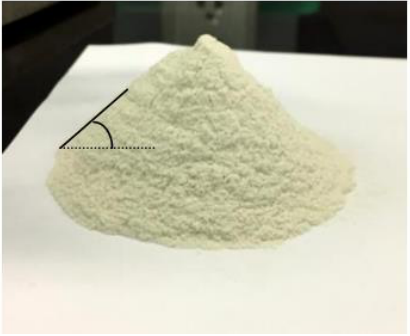
Figure 3. Appearance of co-processed chitosan – kaolin R7.